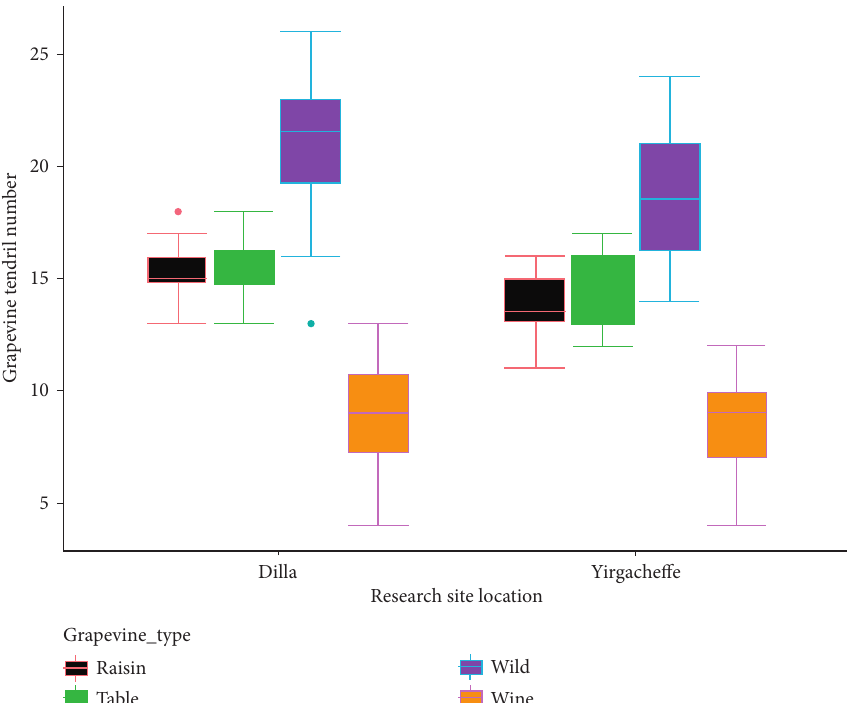
Figure 12: Response of tendril number to grapevine cultivar types and research site